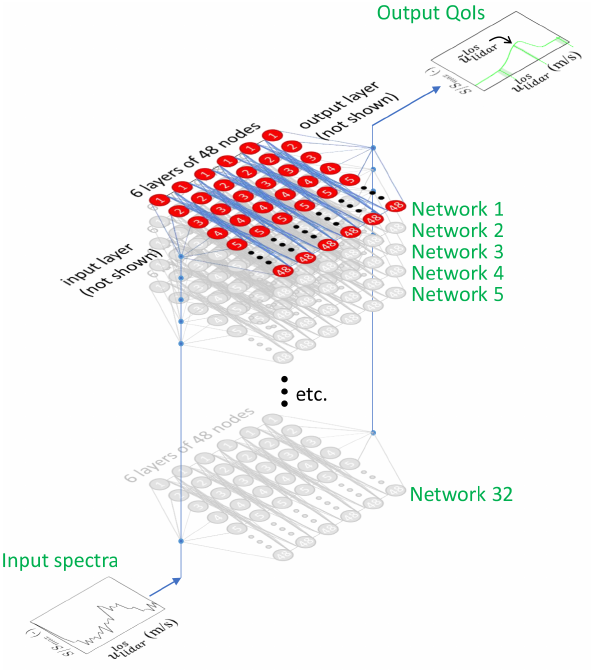
Figure 6. Depiction of the ensemble neural network structure. Note that input and output layers are omitted for